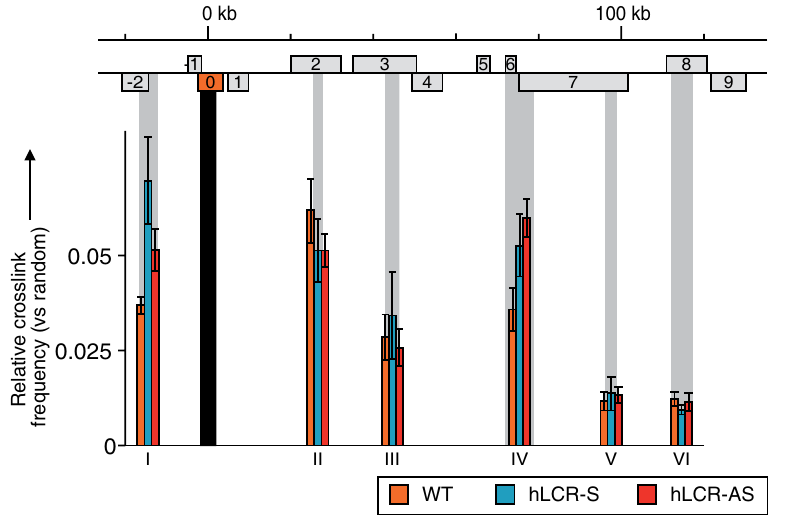
Figure 6. Chromatin looping at 8C3/C4 in the presence of the LCR. Relative crosslink frequencies (vs. random) in a part of the 300 kb region containing the two most upregulated genes (genes 2 2, Dand5 and + 6, Dnase2a ). Crosslink frequencies between the fixed BglII fragment, depicted by a black bar, containing either the WT Rad23a gene or the LCR and other fragments, depicted by gray bars are visualized, as determined by 3C analysis and quantified by qPCR in WT and transgenic E14.5 fetal liver. Note that for the fixed fragment in each strain the same primer and Taqman probe combination was used. Error bars represent SE of at least three independent experiments.